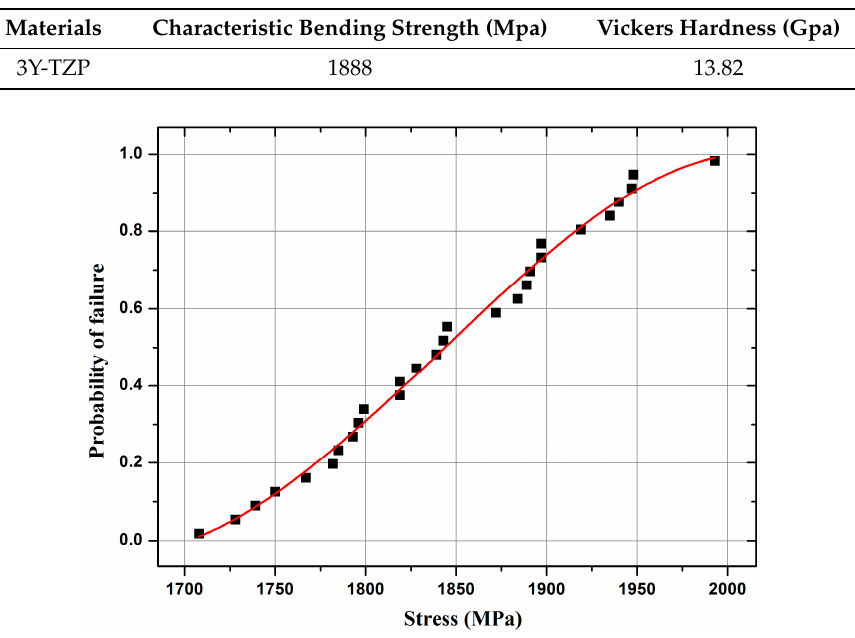
Table 1. Mechanical properties of 3Y-TZP transparent ceramics.